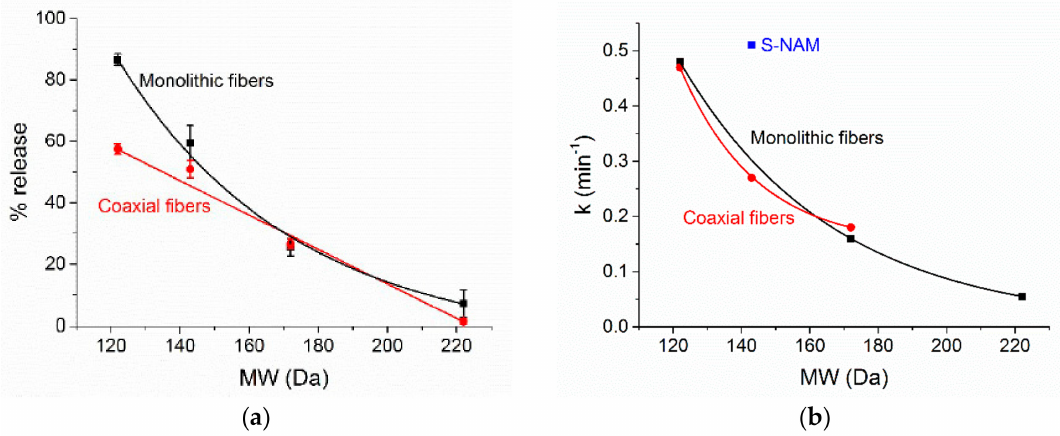
Figure 11. The relationships between AI MW and ( a ) percentage release after 2 h immersion in a pH 1 solution; and ( b ) the Korsmeyer-Peppas rate